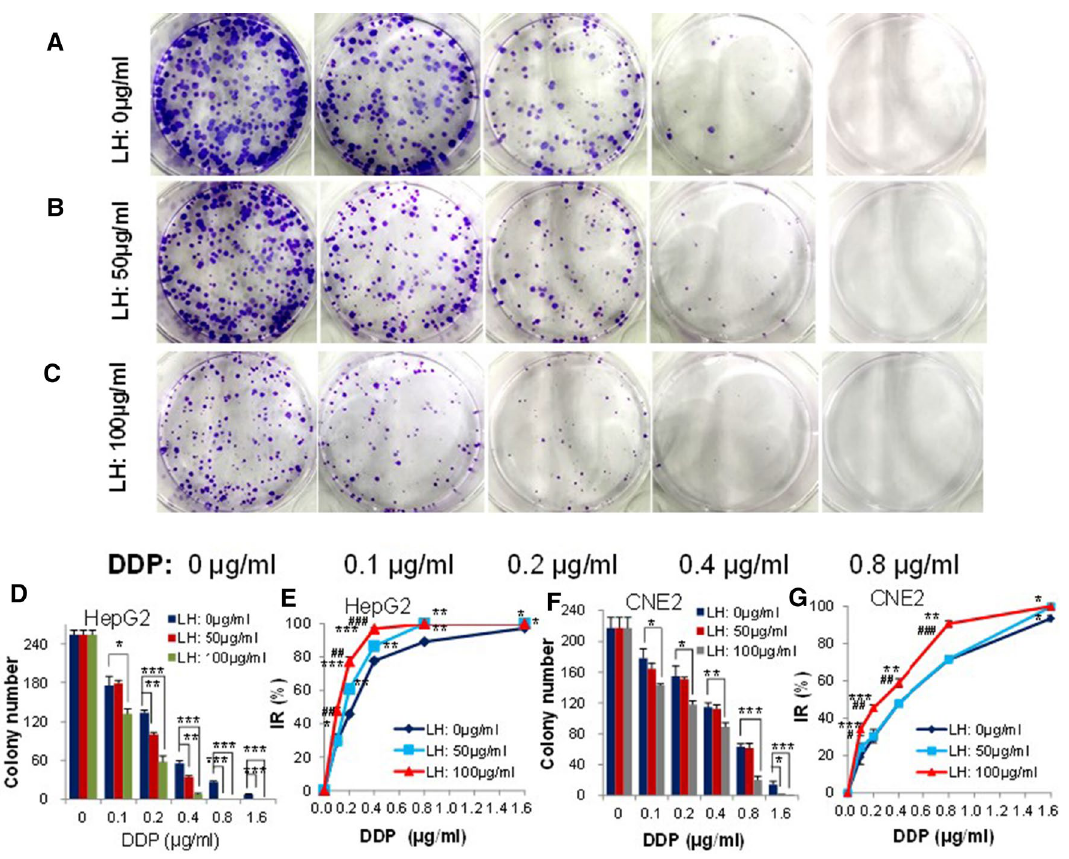
Fig. 2 Levofloxacin concentration-dependently enhances the inhibition of clone formation of cancer cells treated by cisplatin. A–C Example of cloned colony in HepG2 cells treated by different concentrations of DDP in different concentrations of LH medium (0, 50 and 100 μg/ ml). D Summary data of the colony number in HepG2 cells treated by different concentrations of DDP in different concentrations of LH medium (0, 50 and 100 μg/ml). E IR comparison among different concentrations of LH medium (0, 50 and 100 μg/ml) in HepG2 cells treated by different concentrations of DDP. F Summary data of the colony number in CNE2 cells treated by different concentrations of DDP in different concentrations of LH medium (0, 50 and 100 μg/ml). G IR comparison among different concentrations of LH medium (0, 50 and 100 μg/ml) in CNE2 cells treated by different concentrations of DDP. Error bars indicate SD from three independent experiments. * /# p < 0.05, ** /## p < 0.01 and *** /### p < 0.001. *: comparison between LH-free medium (LH: 0 μg/ml) and LH medium (LH: 50 μg/ml or 100 μg/ml) at the same DDP concentration. # : IR comparison between LH medium (LH: 50 μg/ml) and LH medium (100 μg/ml) at the same DDP